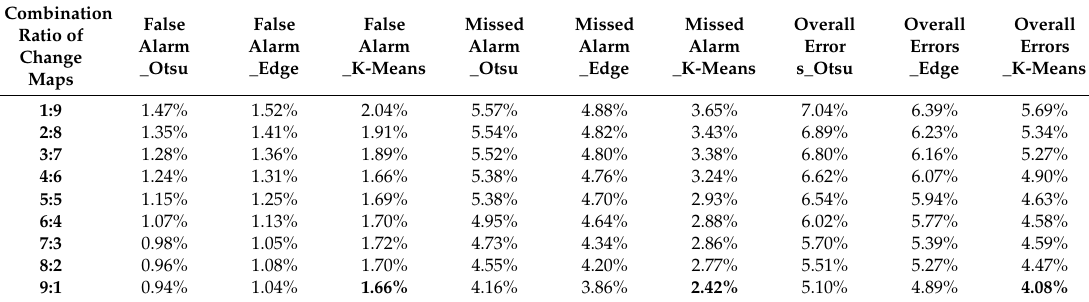
Table 2. Comparison between the change detection results of the three thresholding and clustering methods, with L1 as the basis image in the first study area (scale = 100).